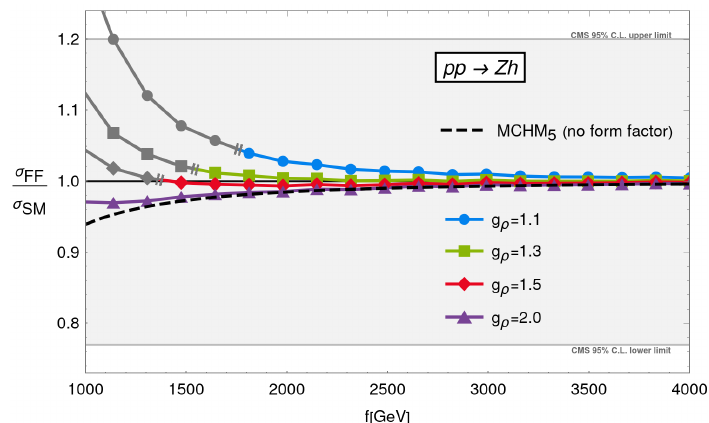
Figure 11 . Normalized Zh cross-section of the ZZh form factor model as a function of f for the √ MCHM 5 . Parton-level signal simulation done in MadGraph5_aMC@NLO at s = 14 TeV. The plot is normalized to the SM prediction. The CHM without momentum dependence has an overall suppression of vertices with κ V . The dashed black curve depicts such suppression. By turning on the form factor effects, we get an enhancement due to the analytic structure of their expressions. The colored curves respect the bounds from direct resonance searches, and the gray curve points above the double lines are excluded by the direct searches for vectorial resonances. The gray band is the CMS 95% confidence level bound on the experimental cross-section over SM